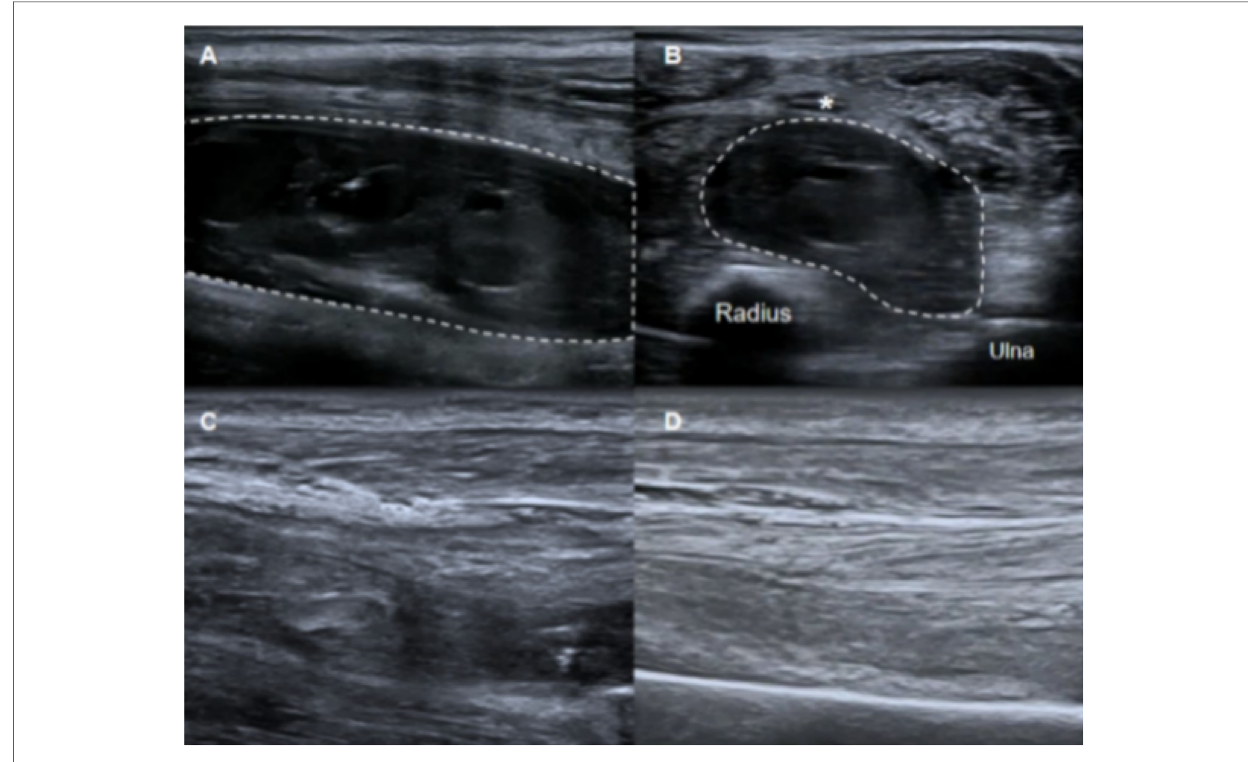
FIGURE 1 A bone traction device was fastened to the patient ’ s right leg ( A ). Ultrasound examination revealed a heterogeneous echo mass in the lateral muscles of the right calf ( B ). A 12-F drainage tube was inserted into the hematoma ( C ). Five days after drainage and urokinase lavage, ultrasonography showed signi fi cantly decreased hematoma volume ( D